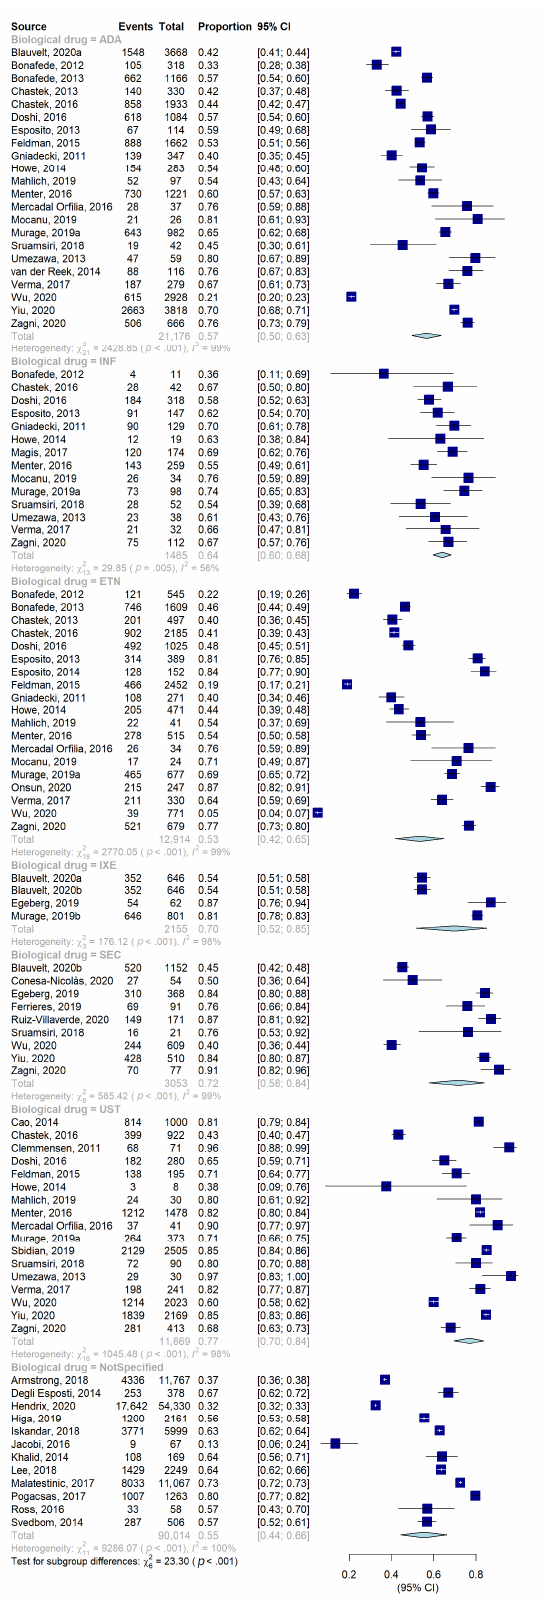
Figure 6. Forest plot of proportions, and their 95% confidence intervals, of persistent patients stratified according to biological